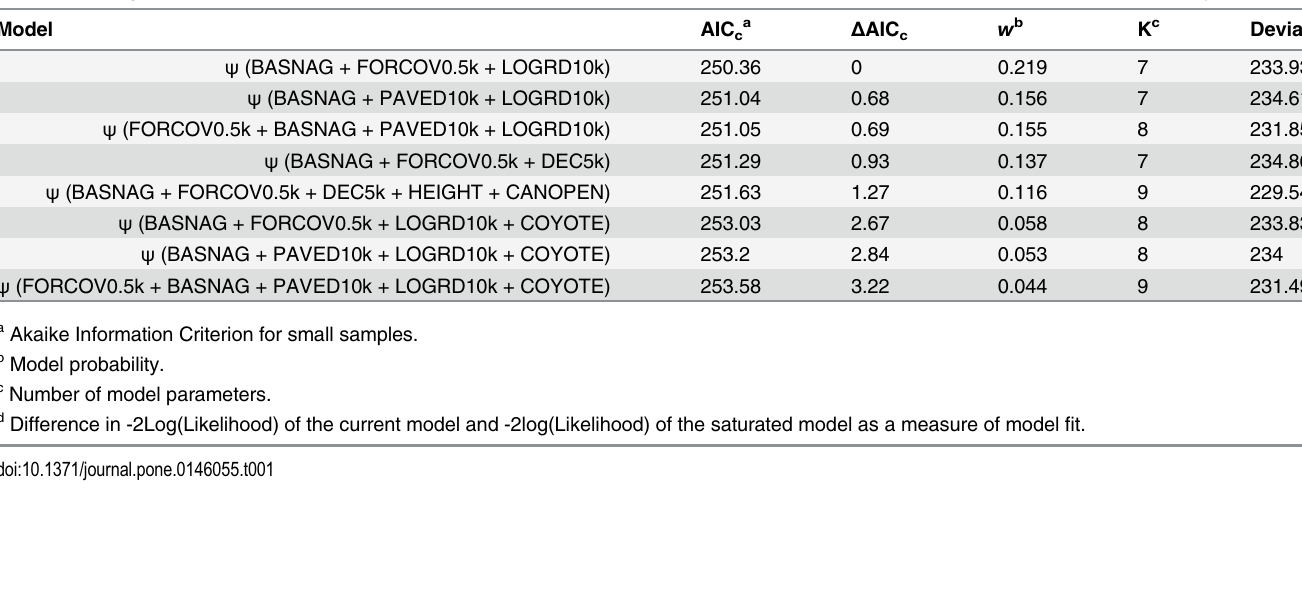
Table 2. Fisher co-occurrence models. Co-occurrence model selection results in the 90% confidence set for M . pennanti with the inclusion of U . ameri- canus , C . latrans , and P . lotor . We fit encounter history data from surveys at 54 sites in Adirondack Mountains, New York, USA to each candidate model set. Co-occurrence models were fit using important detection parameters and estimated occupancy, except C . latrans models which were fit using estimated abundance. See S1 Table for habitat variable descriptions.